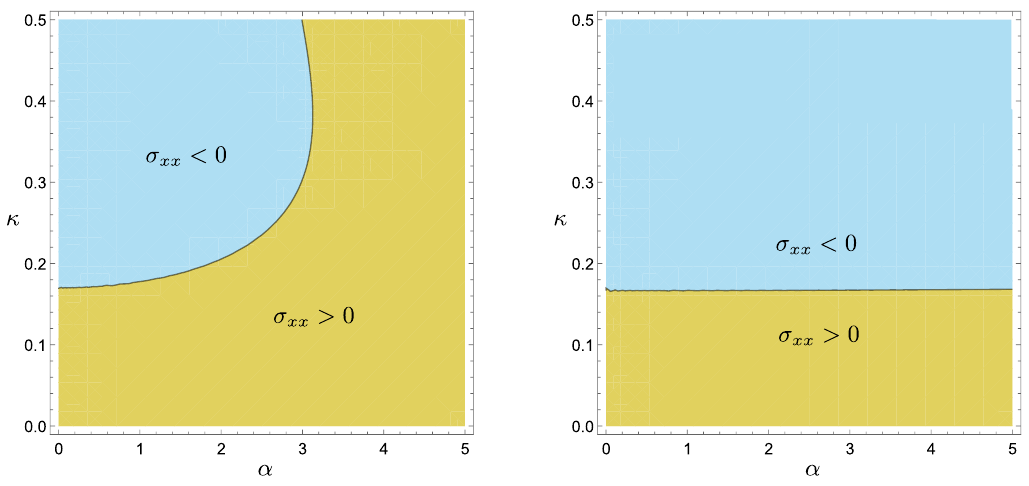
Figure 2 . Distribution of the sign of (cid:27) xx as a function of the disorder strength (cid:11) and the coupling constant (cid:20) for the Exponential model. The left plot is for ( T = 0 ; B = 10) and the right one for ( T = 0 ; B = 1000). The blue regions denote negative conductivity and the yellow regions correspond to positive conductivity. To avoid a negative value of (cid:27) xx , (cid:20) should be smaller than 0 : 167. We have worked in units with the charge density (cid:26) =